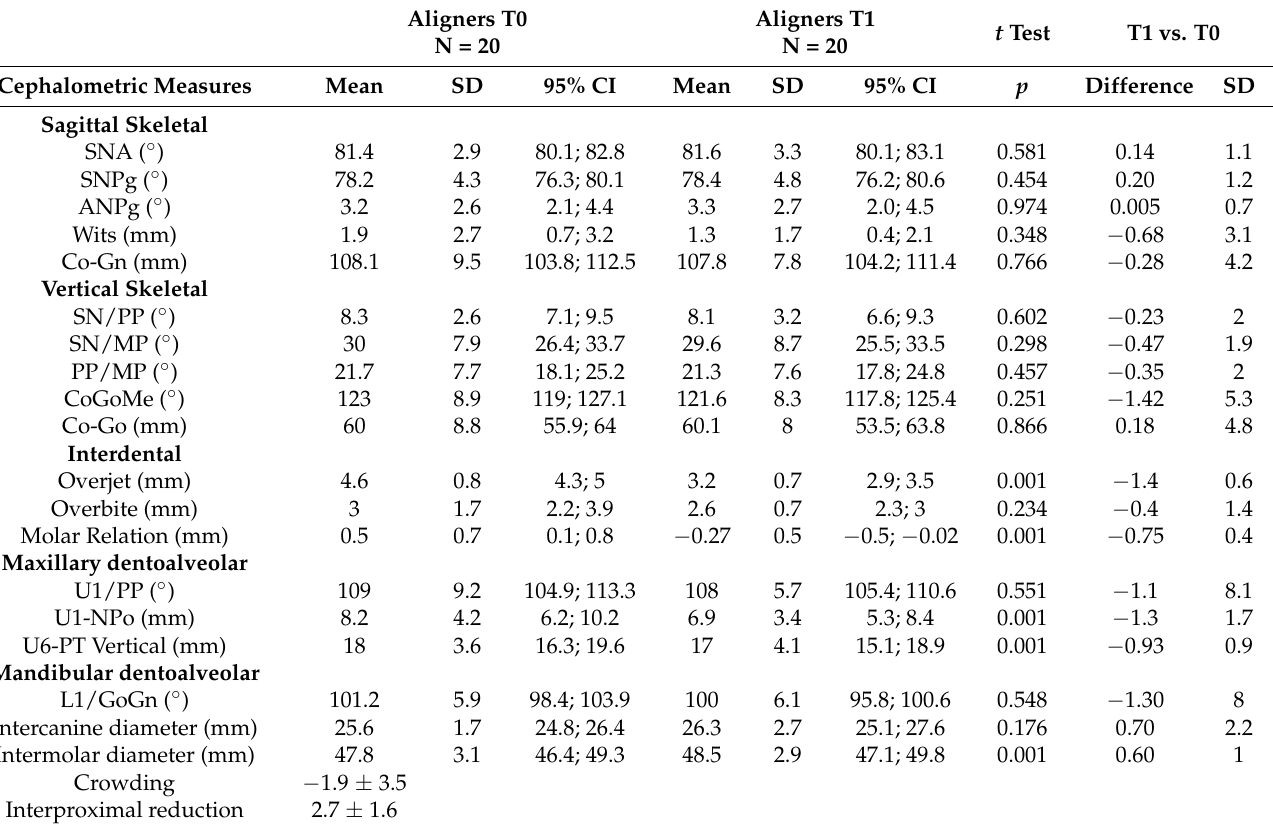
Table 2. Descriptive statistics and statistical analysis T1 vs. T0. The significance level was set at p < 0.05. Data are reported as mean ± standard deviation (SD) and 95% confidence interval (95%